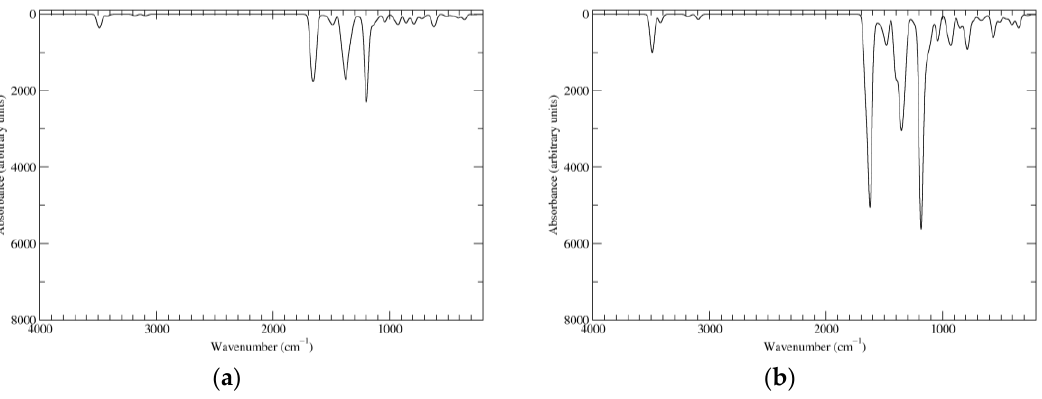
Figure 10. Computed IR spectra of the most significant tautomers/conformers in the six-electrons oxidation state. ( a ) Neutral form in vacuo, a16_b6_c16_d6, C 2 , conf1. ( b ) Neutral form in water, a16_b6_c16_d6, C 2 , conf1.